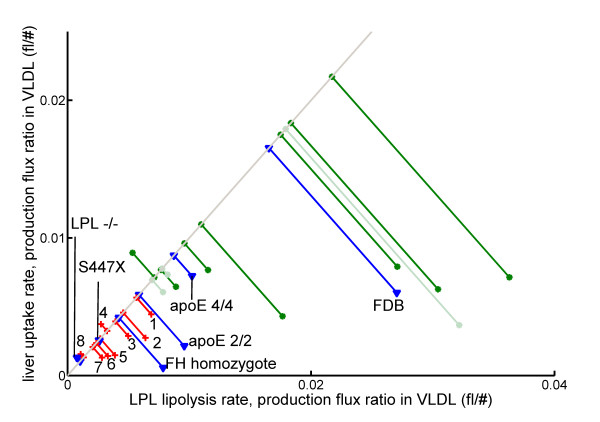
The average VLDL performance of various subject groups. Green lines with round ends are normolipidemic subject groups. Groups indicated with darker green were used for the ROC curve in figure 3, those indicated with light green were not. Red lines with crosses represent dyslipidemic subject groups used for the ROC curve. Groups are labeled as follows: 1) hypothyroid patients during T4 treatment [26]; 2) subjects with small LDL peak size [18]; 3 and 8) mixed hyperlipidemia [24,25]; 4) hypothyroid patients before treatment [26]; 5) kidney disease: membranous glomerulonephritis [21]; 6) patients on HIV treatment [23]; 7) kidney disease: focal segmental glomerulosclerosis [21]. Blue lines with triangles indicate subject groups with specific genetic variant. FDB: Familial Defective ApoB (mostly heterozygote) [29]; FH: Familial Hypercholesterolemia (homozygote) [19]; S447X: specific single nucleotide polymorphism in the LPL gene [30].